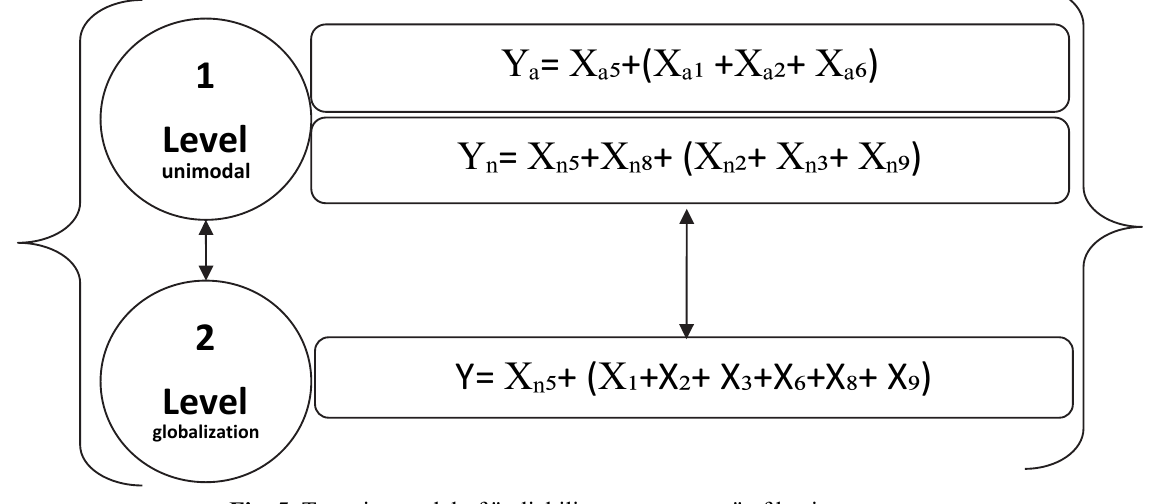
Fig. 5. Two-tier model of "reliability management" of business